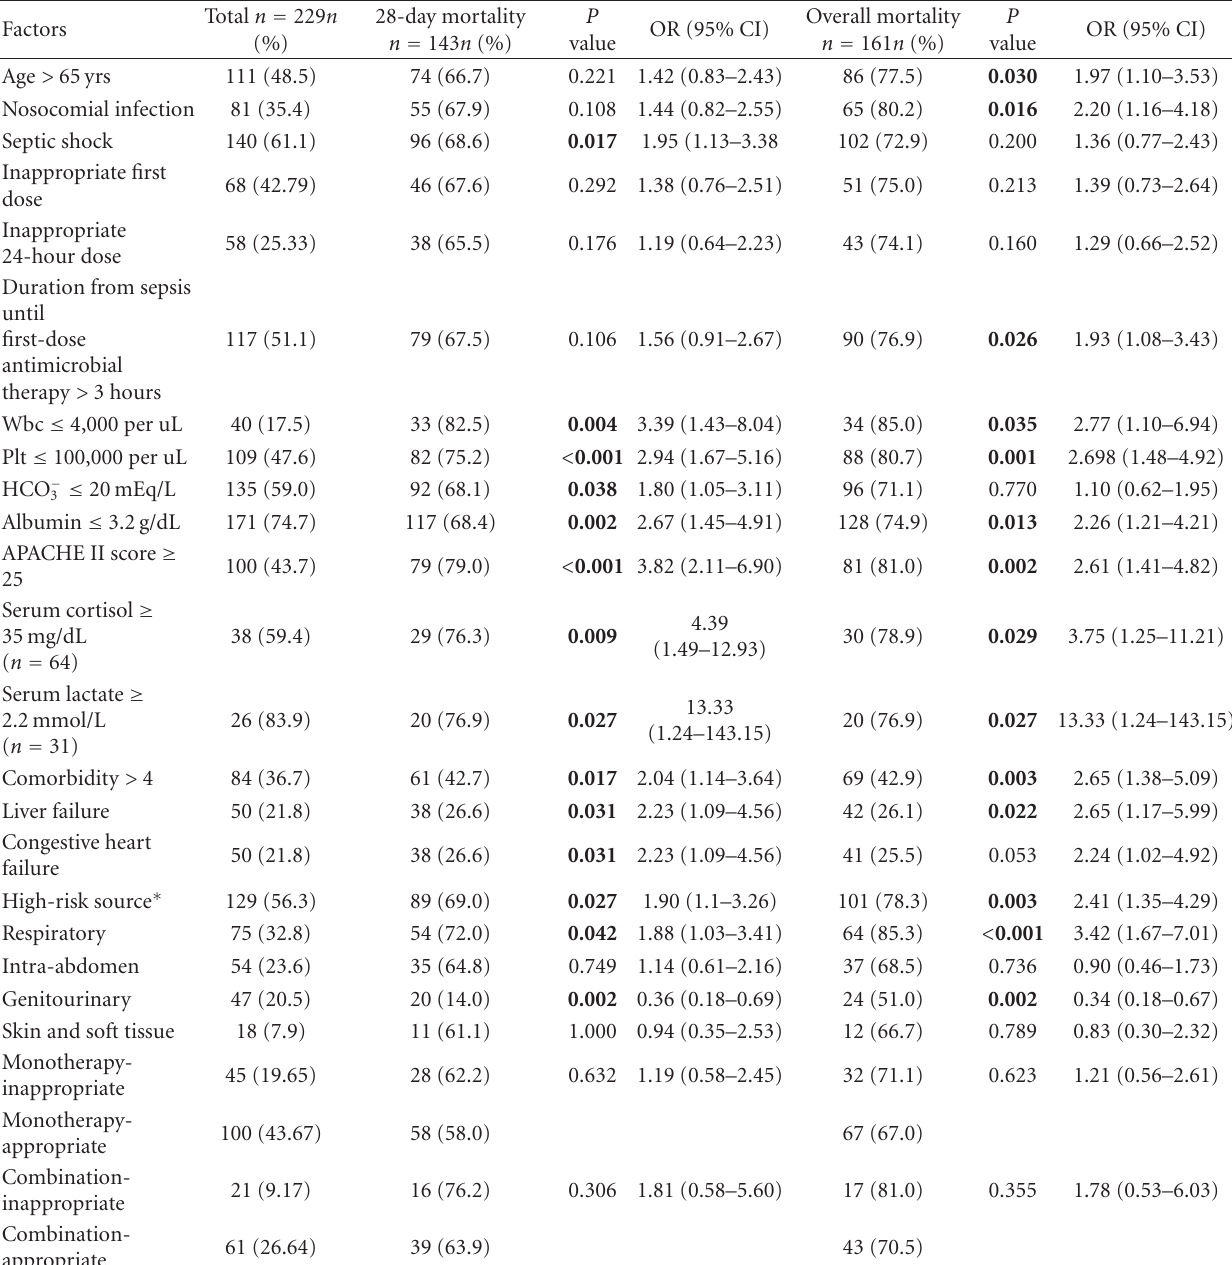
Table 5: Univariate analysis of factors associated with 28-day and overall